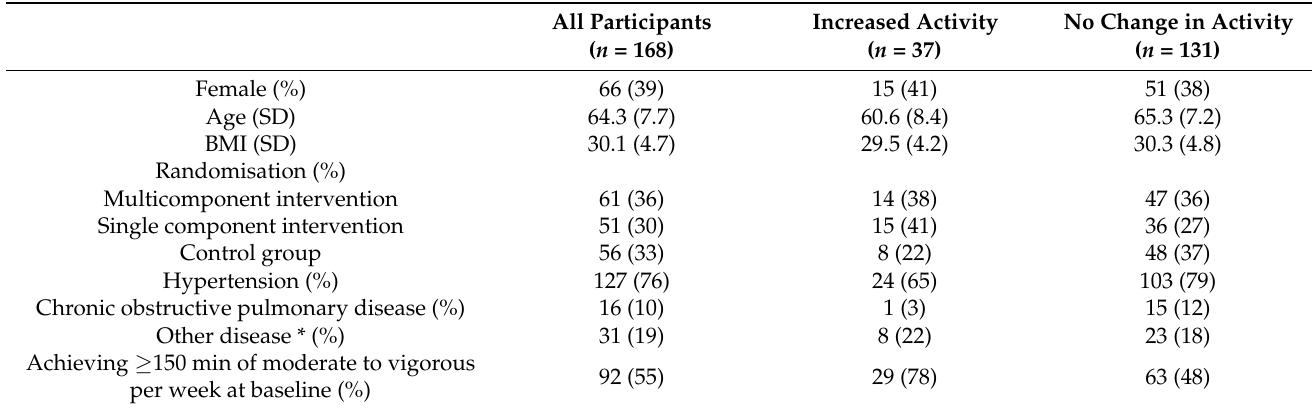
Table 2. Baseline characteristics of the study sample for all participants and by profile, with mean (SD) or number